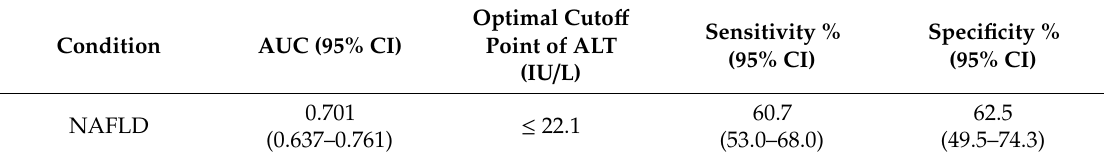
Table 3. Results of receiver operating characteristics for alanine aminotransferase (ALT) to predict NAFLD among T2DM in Abha city.